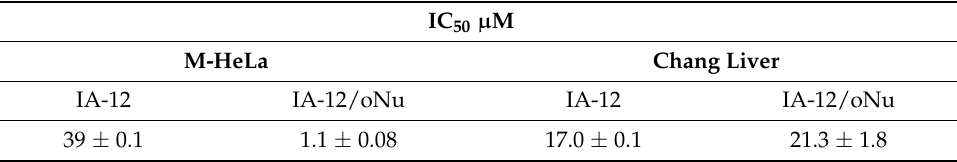
Table 2. The cytotoxic effect of IA-12 in the individual system and in the binary system with oNu toward normal and tumor human cell lines.